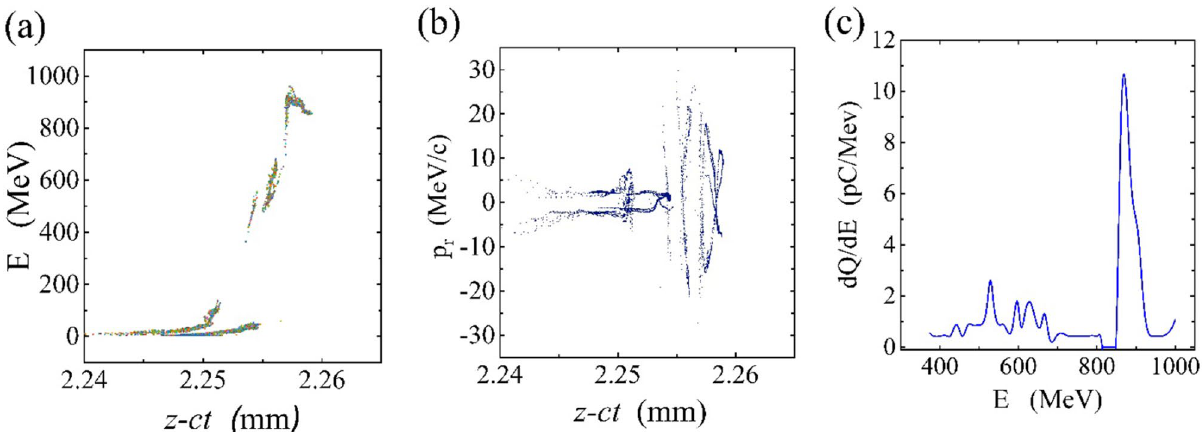
Figure 3. The phase space of self-trapped electrons for a hybrid accelerator after 2.3 mm propagation. Energy gain from the wake ( a ), Transverse momentum vs. propagation distance ( b ), and electron energy spectrum ( c ).